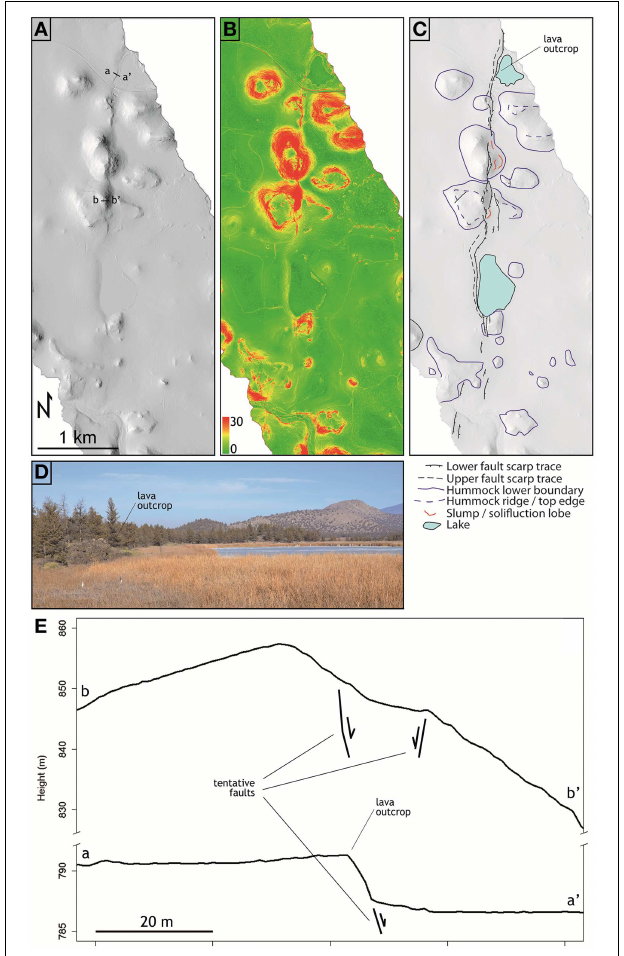
FIGURE 3 | Detail of the LiDAR data of the faulted area. (A) Shaded relief DTM (sun elevation 45 ◦ , azimuth 270 ◦ ) with trace of the vertical profiles in (E) . (B) Slope image. (C) Geomorphological interpretation and location of the lava outcrop. (D) North view of the vertical outcrop of lava cut by the LiDAR-detected fault as marked in (C) . (E) Vertical profile of the faulted area: (a-a’) lava outcrop and (b-b’) interhummock.